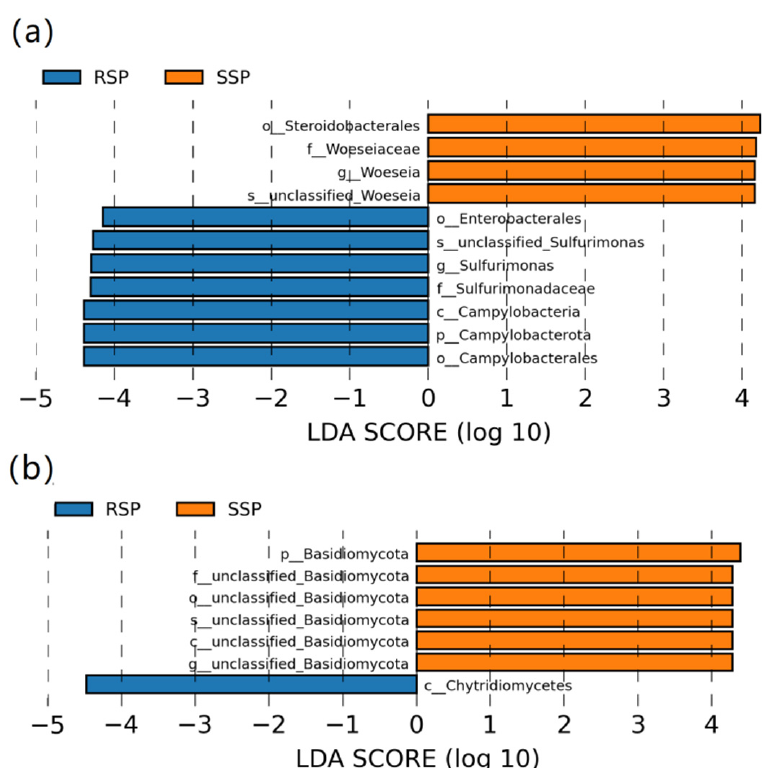
Figure 4. LEfSe analysis showing the significant difference at different bacterial ( a ) and fungal ( b ) taxonomic levels between the SSP and RSP groups. Different colors represent different groups.